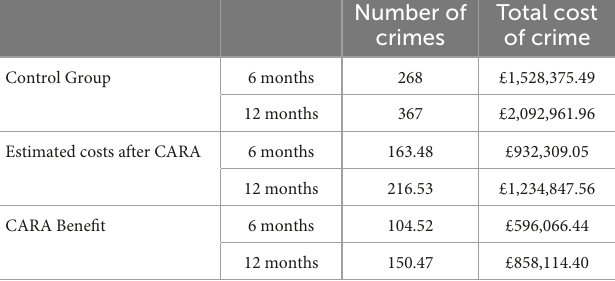
TABLE 14 Economic benefits of the CARA service (Hampshire Constabulary).